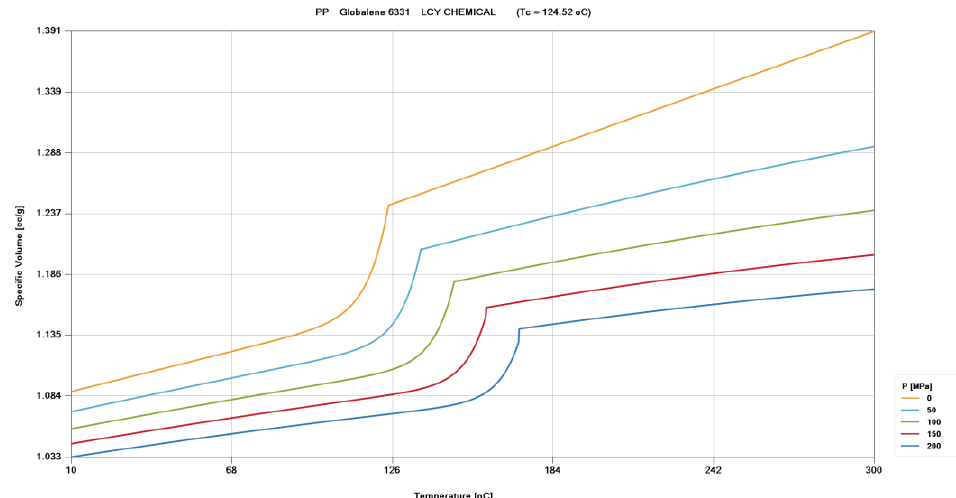
Figure 1. P-V-T relationship of PP-6331 (source: Moldex3D 2022).